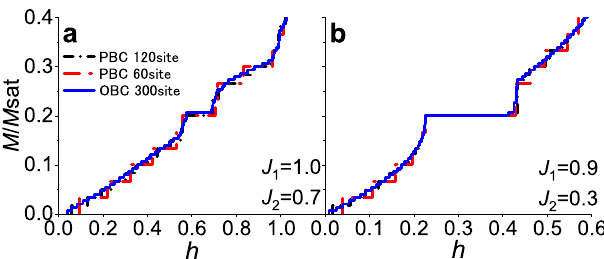
Fig. 4 Magnetization curves in phases II and III as a function of the magnetic fi eld. The black, red, and blue solid lines show the results of the periodic boundary condition for N = 60, periodic boundary condition for N = 120, and open boundary condition for N = 300, respectively, at zero temperature, where N is the number of sites. In addition, M is the magnetization, M sat is the saturation magnetization, and h is the magnitude of the magnetic fi eld. a J 1 = 1.0 and J 2 = 0.7 (phase II). b J 1 = 0.9 and J 2 = 0.3 (phase III). J 1 and J 2 are the exchange interactions shown in Fig. 1.